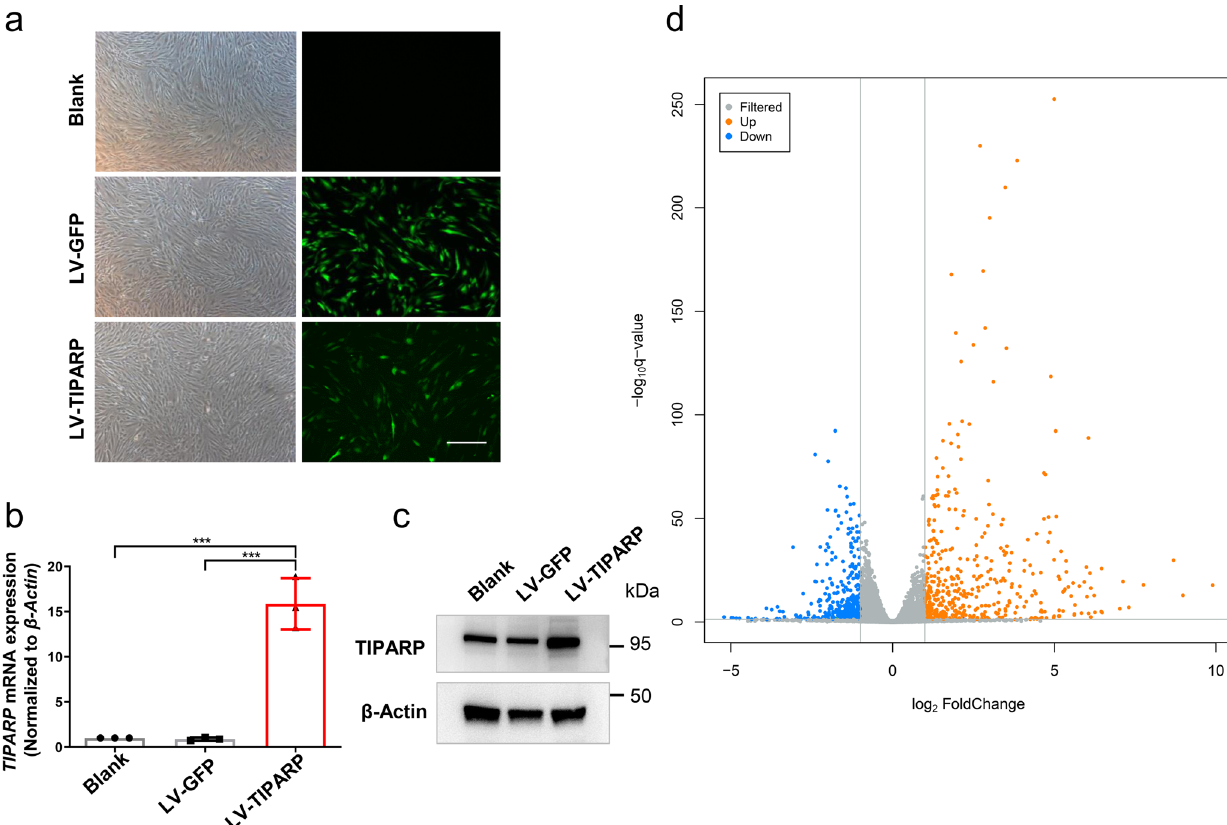
Fig. 3 Transcriptome analysis of TIPARP overexpressing HTM cells. a Bright- fi eld and fl uorescence micrographs of HTM cells transduced with TIPARP encoding lentivirus (LV-TIPARP) and scrambled lentivirus (LV-GFP). Green fl uorescence indicated successful transduction in the cell. The transduction ef fi cient was 57.50% ± 1.94% in LV-GFP group and 50.21% ± 1.50% in LV-TIPARP group. b qRT ‒ PCR showed that LV-TIPARP transduction signi fi cantly increased TIPARP expression compared with that of blank cells and LV-GFP cells ( n = 3, P < 0.001). c Western blot con fi rmed that LV-TIPARP transduction increased TIPARP protein expression compared with that in the LV-GFP cells. d Volcano plot showing 499 upregulated and 390 downregulated genes in the LV-TIPARP cells compared with the LV-GFP cells in total (fold change >1.5 or <0.6, q value < 0.05, n = 3 independent replicates for each group). Data are presented as the means ± standard deviations. *** P < 0.001. Scale bar = 50 μ